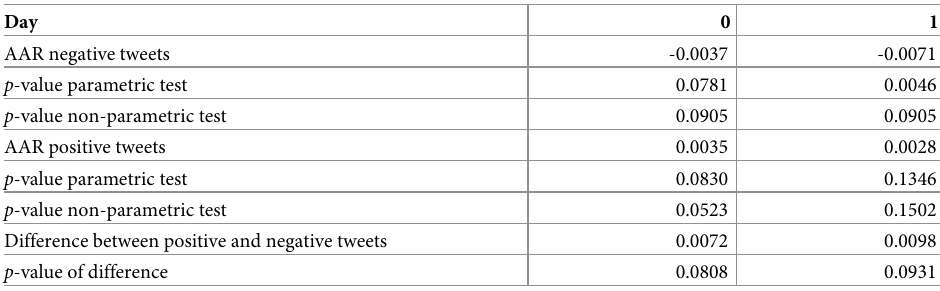
Table 3. Comparing the response to tweets with negative and positive